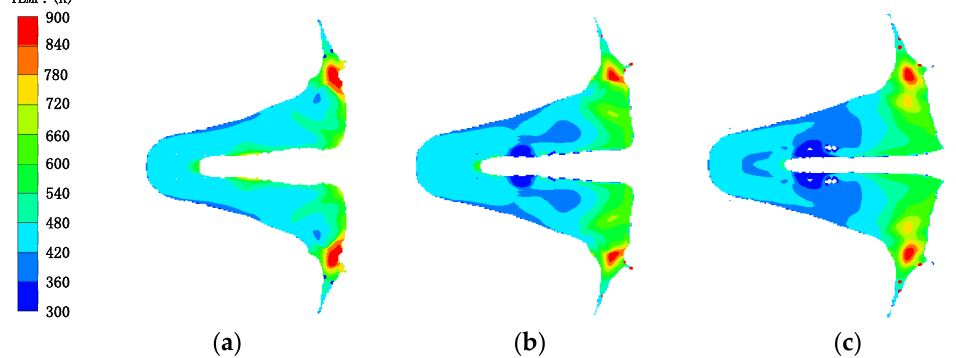
Figure 13. Temperature distribution of the reactive material slug under different composite jets: ( a ) reactive material – Cu jet; ( b ) reactive material – Ti jet; ( c ) reactive material – Al jet.